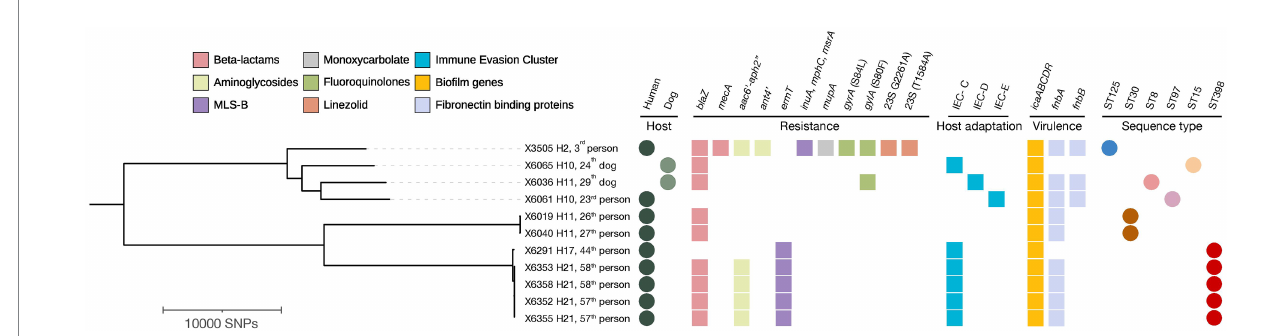
FIGURE 3 Phylogenetic tree based on core genome SNP analysis of 11 MRSA, MSSA-CC398, and other MSSA isolates from households with ≥ 2 humans and/or dogs’ carriers. The presence of antimicrobial resistance genes, immune evasion cluster (IEC), icaABCDR operon, fibronectin binding proteins, host type and sequence types (ST) are indicated. The filled circles indicate hosts and sequence types while the filled and squares indicate the confirmed antimicrobial resistance, host adaptation markers and virulence determinants extracted from MLST 2.0, ResFinder, PointFinder and VirulenceFinder. Visuals were obtained using iTOL v6.6. MLS-B, Macrolide-Lincosamide-Streptogramin-B. H,